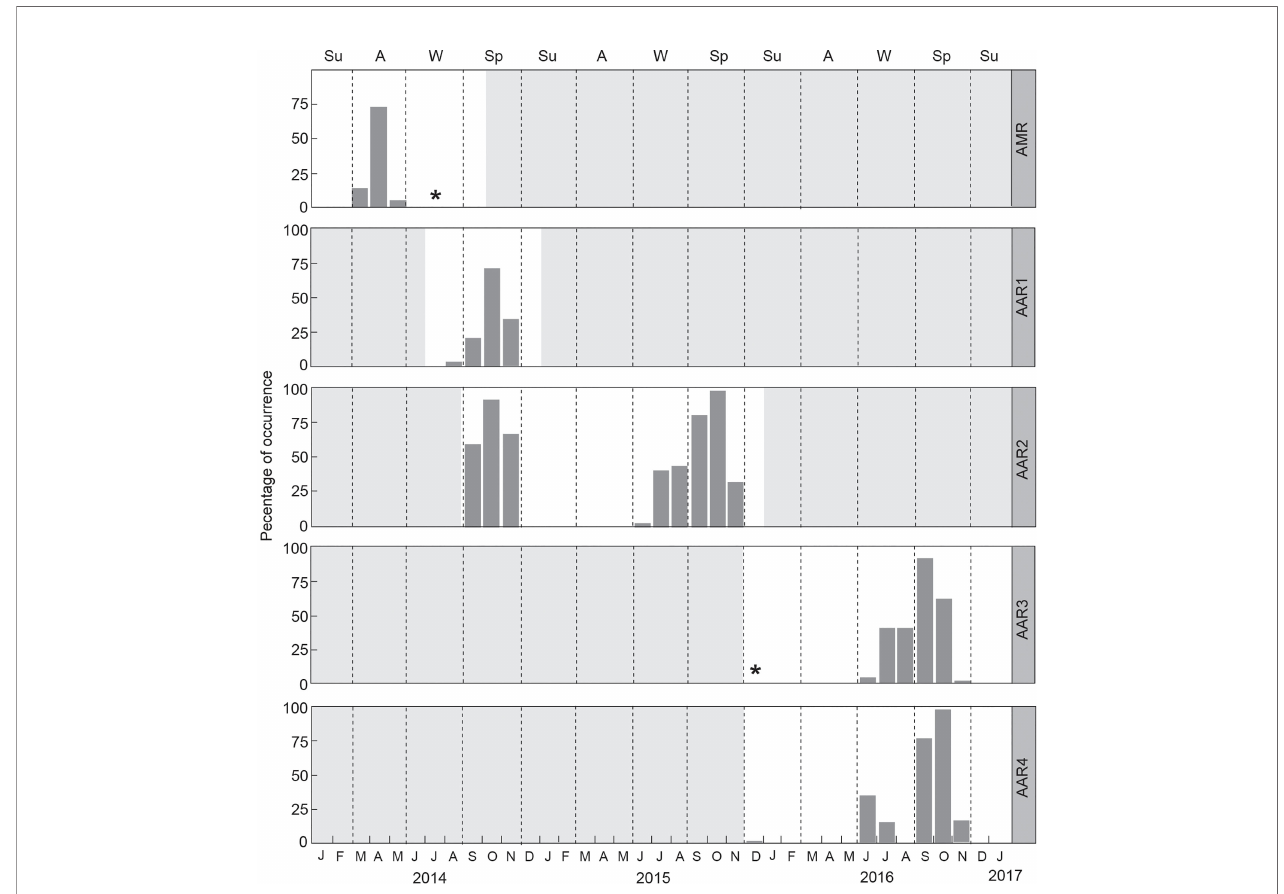
FIGURE 3 | Monthly percentage of acoustic occurrence of male humpback whale songs off the west coast of South Africa and Maud Rise, Antarctica. Asterisks represent cases when the monthly percentage of acoustic occurrence was less than 0.5%. Gray shaded areas designate periods without passive acoustic monitoring effort. Su is summer, A is autumn, W is winter, and Sp is spring are shown on the top axis and de fi ned by dashed lines, and years are stated on the bottom